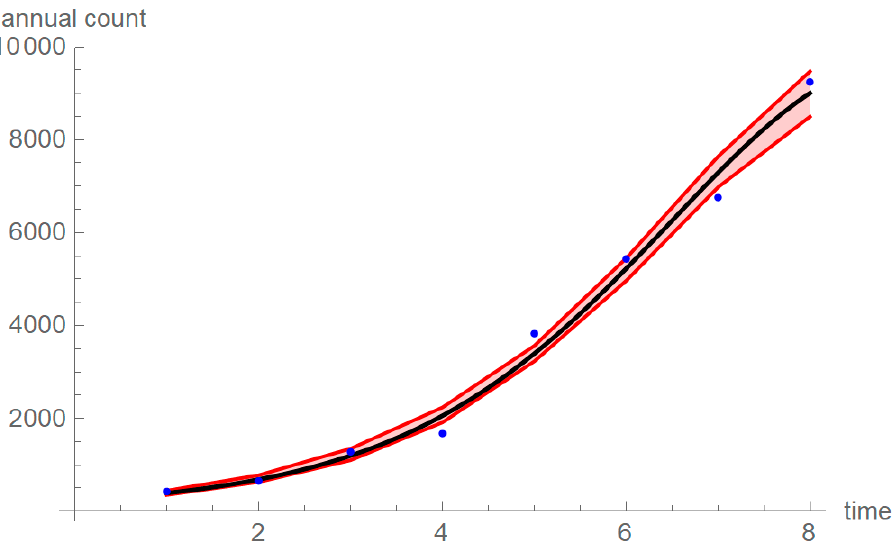
Figure 3. Annual registrations of electric cars in Austria from 2012 to 2019. Note: blue dots are the registrations (sales) x t , the black line is the derivative y ′ ( t – ts ) of the best-fit curve from Figure 2, using a time shift ts = 0.5, and the red band restricts the range of the derivatives of growth curves with red exponent pairs (Figure 1); plot using Mathematica 12.1.